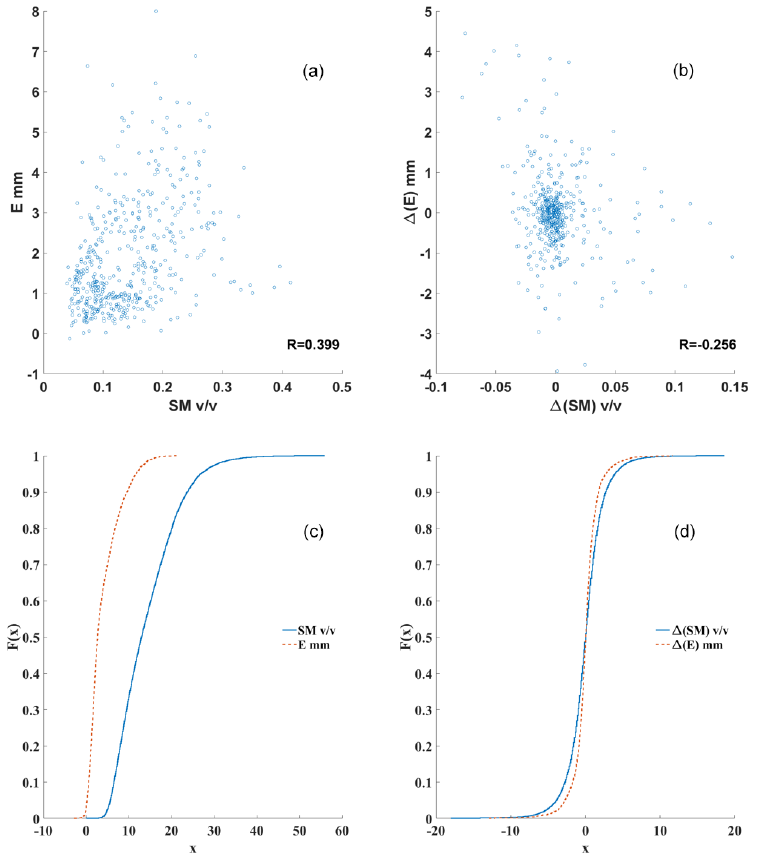
Figure 2. (a) Scatter plot of average daily soil moisture vs. daily evaporation; (b) scatter plot of day-to-day change in average daily soil moisture vs. day-to-day change in daily evaporation; (c) cumulative distributions of average daily soil moisture and daily evaporation; (d) cumulative distributions of day-to-day change in average daily soil moisture and daily